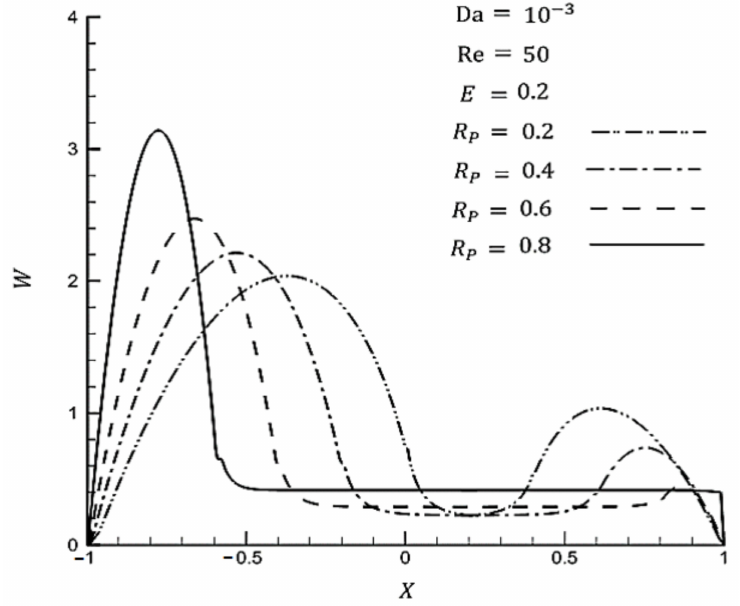
Figure 17. Effect of porous medium thickness on fully developed velocity profile in eccentric